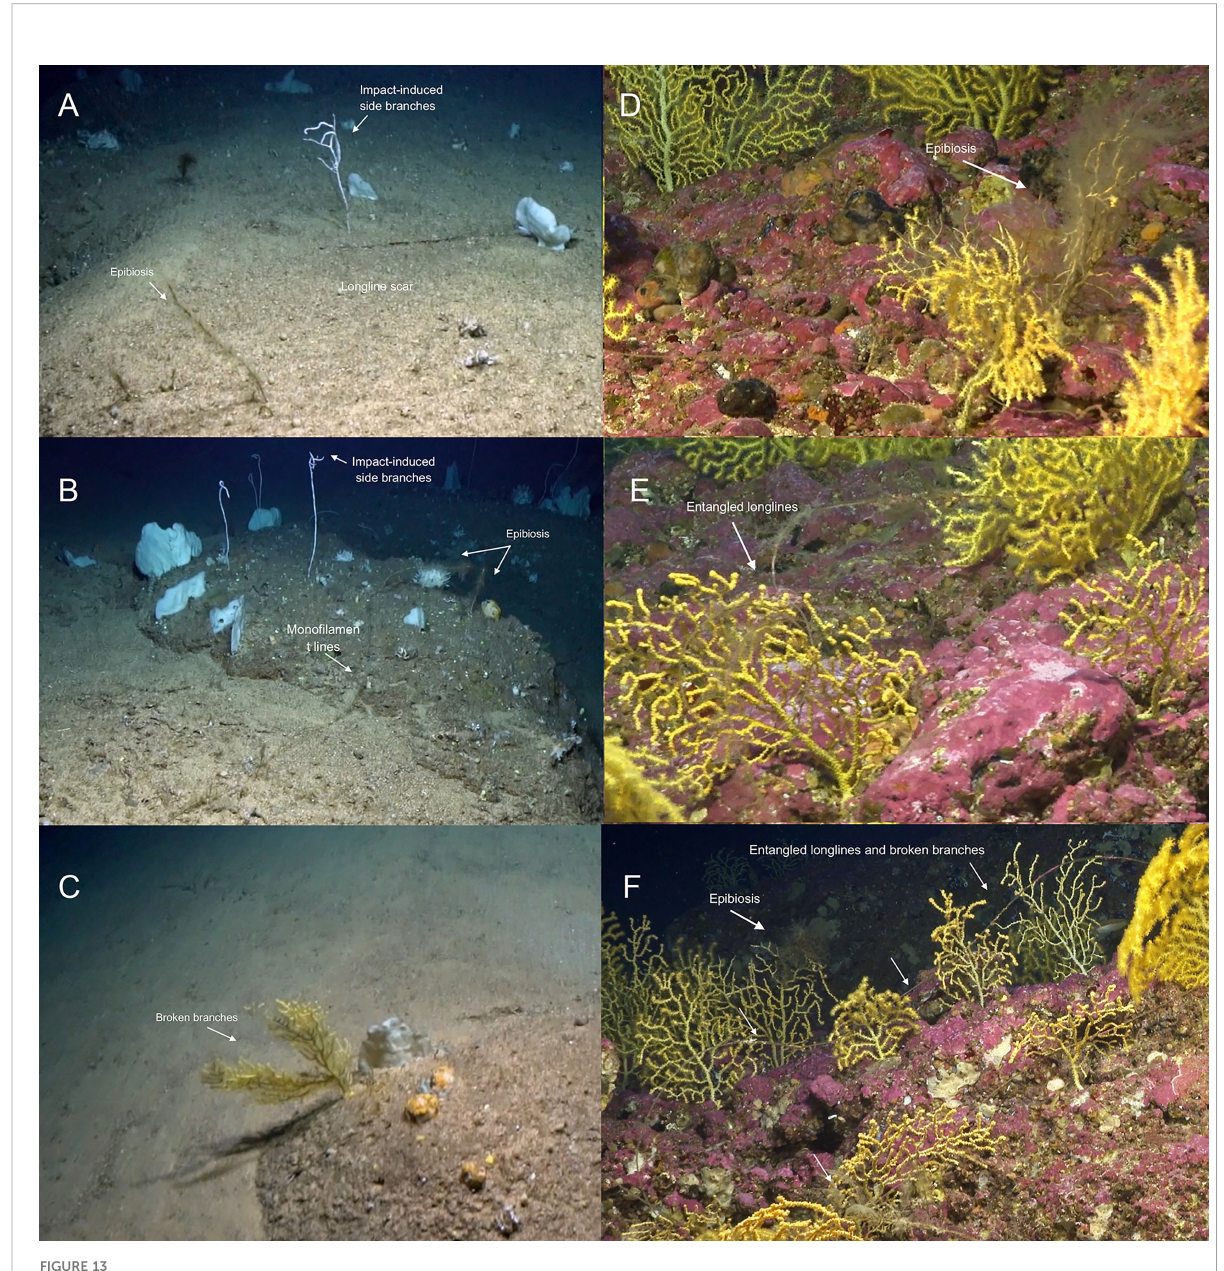
FIGURE 13 Examples of impacted alcyonacean gorgonians. (A – C) : from the deep Viminella garden, (D – F) : from the shallow Paramuricea